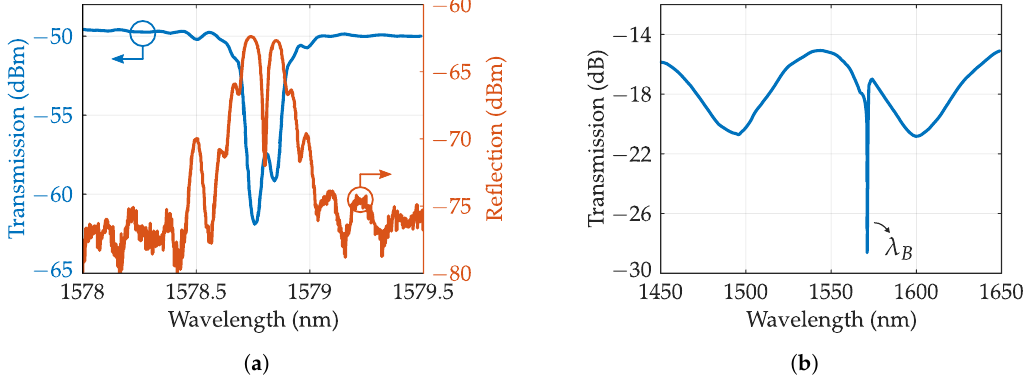
Figure 14. ( a ) Transmission and reflection spectra of bubble-based phase-shifted FBG, reproduced from [136]. ( b ) Transmission spectrum of cavity-based MZI embedded in FBG, reproduced from